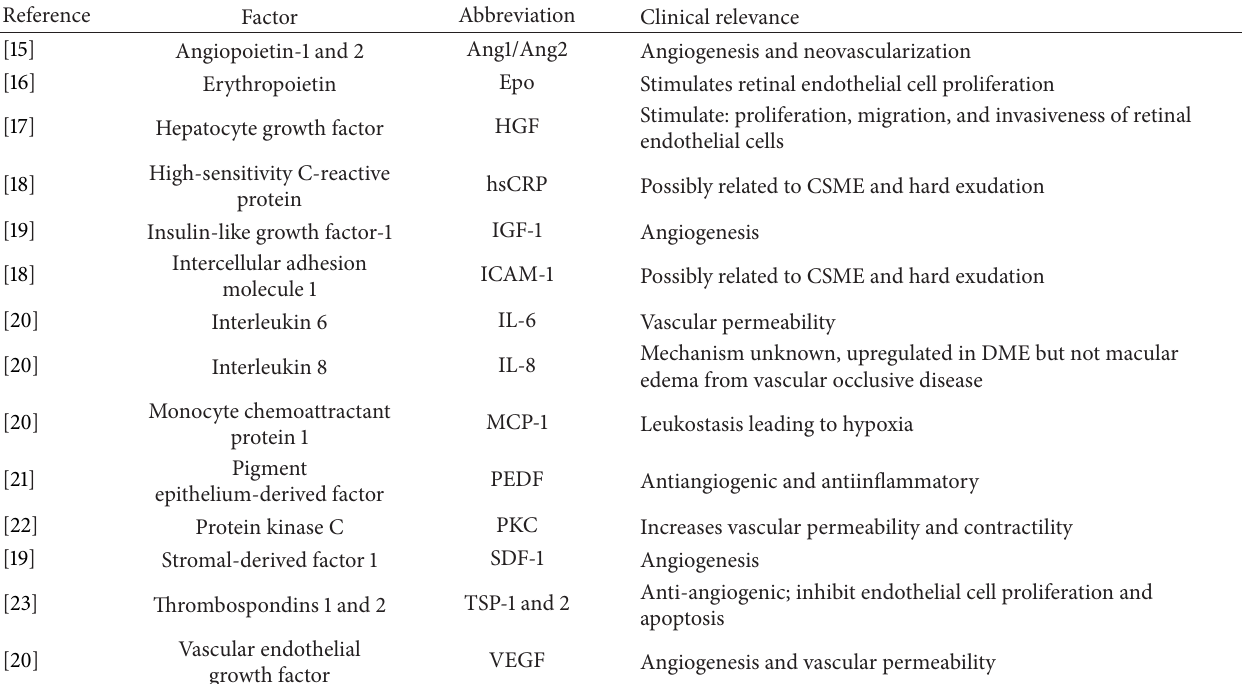
Table 1: Inflammatory factors suggested to play a role in